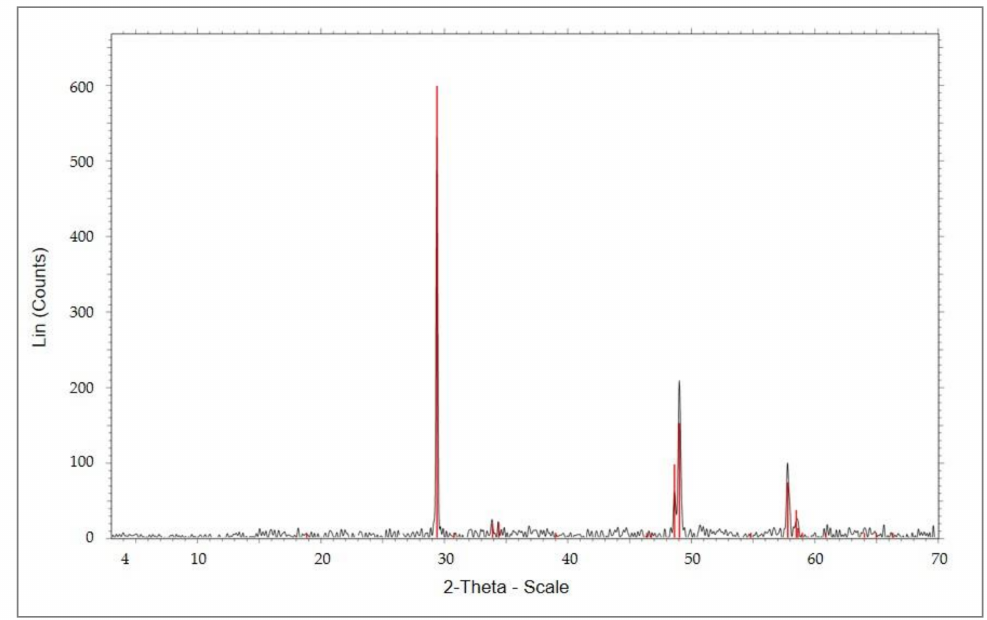
Figure 2. XRD analysis of